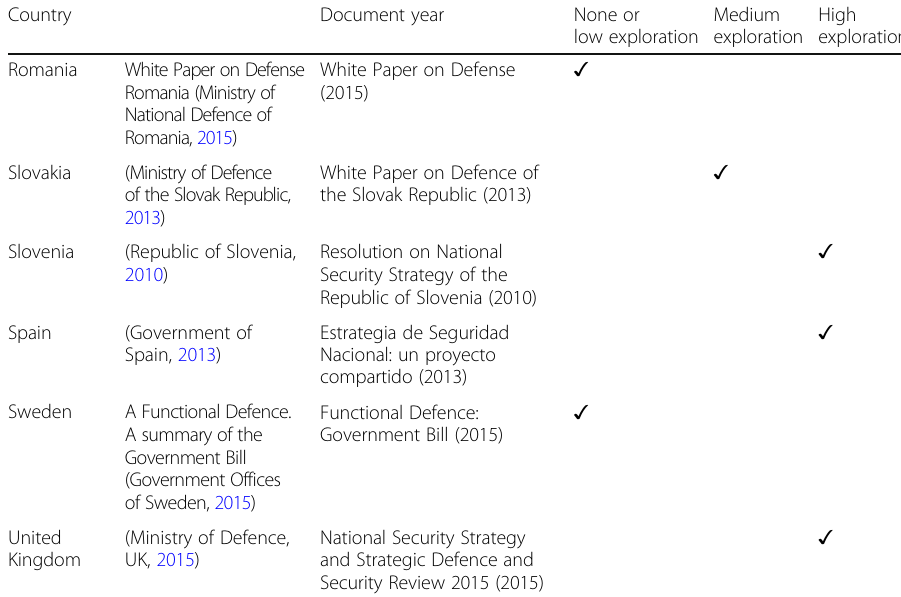
Table 1 Migration-security nexus in national security and defence strategies (Continued)